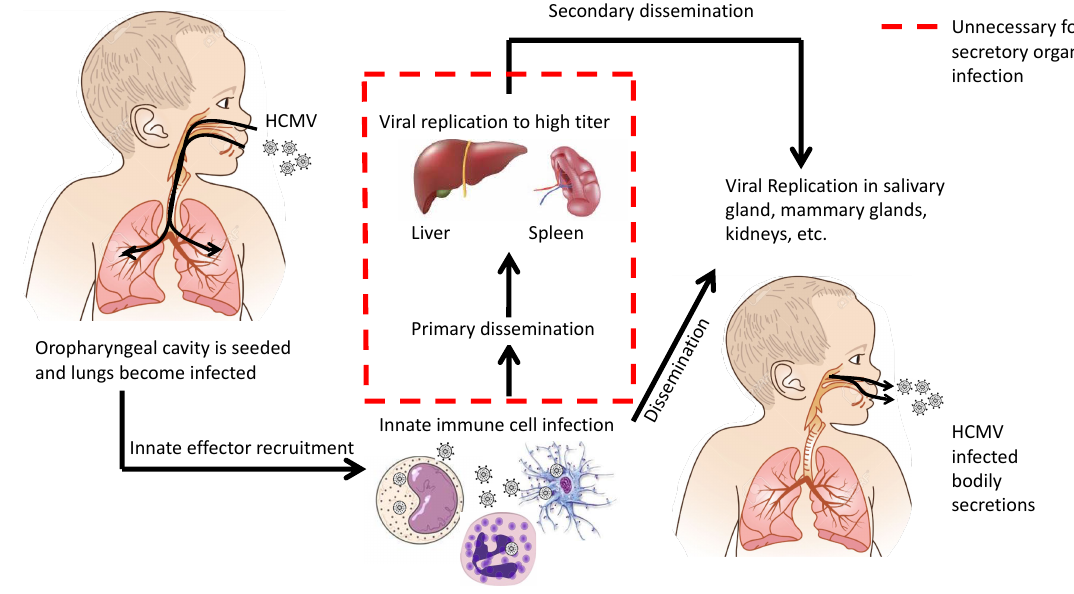
Figure 3. Alternative mechanism of HCMV dissemination generated from animal model